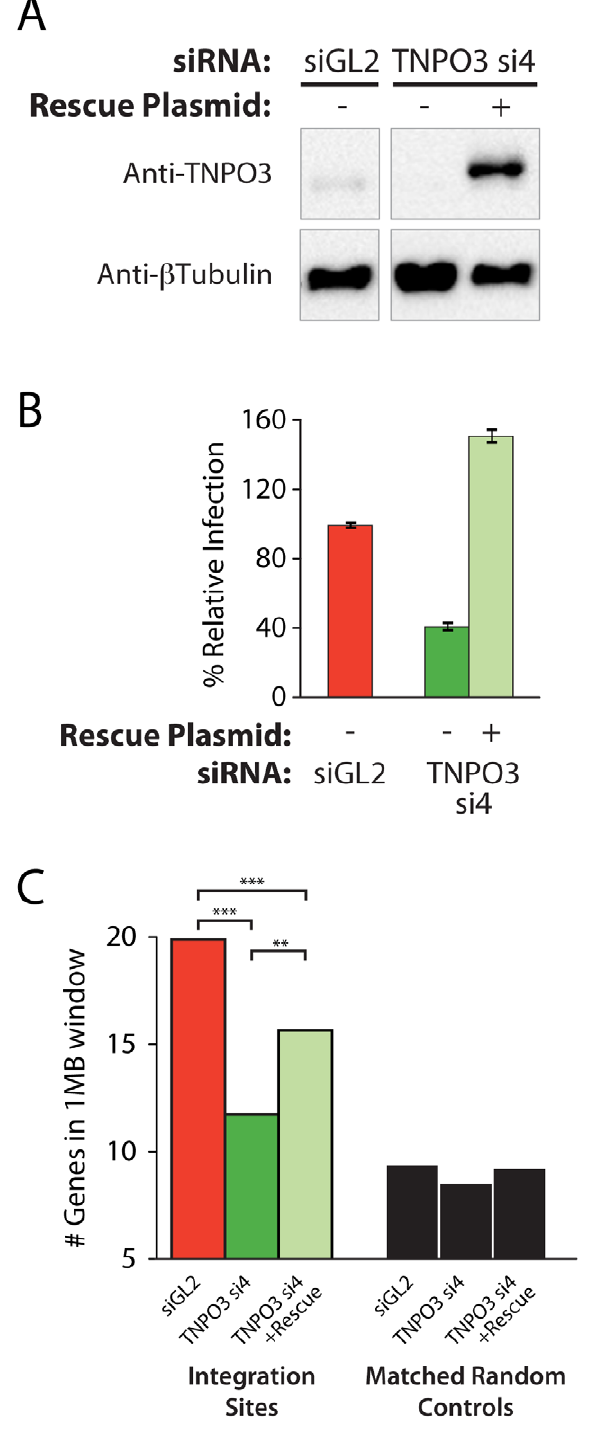
Figure 3. Transfection of a Transportin-3 allele insensitive to TNPO3 si4 restores protein expression, HIV infectivity, and partially restores wild-type HIV integration site distributions. (A) Western blot showing Transportin-3 levels in cells treated with TNPO3 si4 in the presence or absence of the Transportin-3 rescue plasmid. Cells were cotransfected with siRNA and either empty vector plasmid or rescue plasmid encoding siRNA-resistant alleles of Trans- portin-3 expressed from the CMV promoter and harvested at 48 hr post-transfection for analysis. Transportin-3 is reduced after